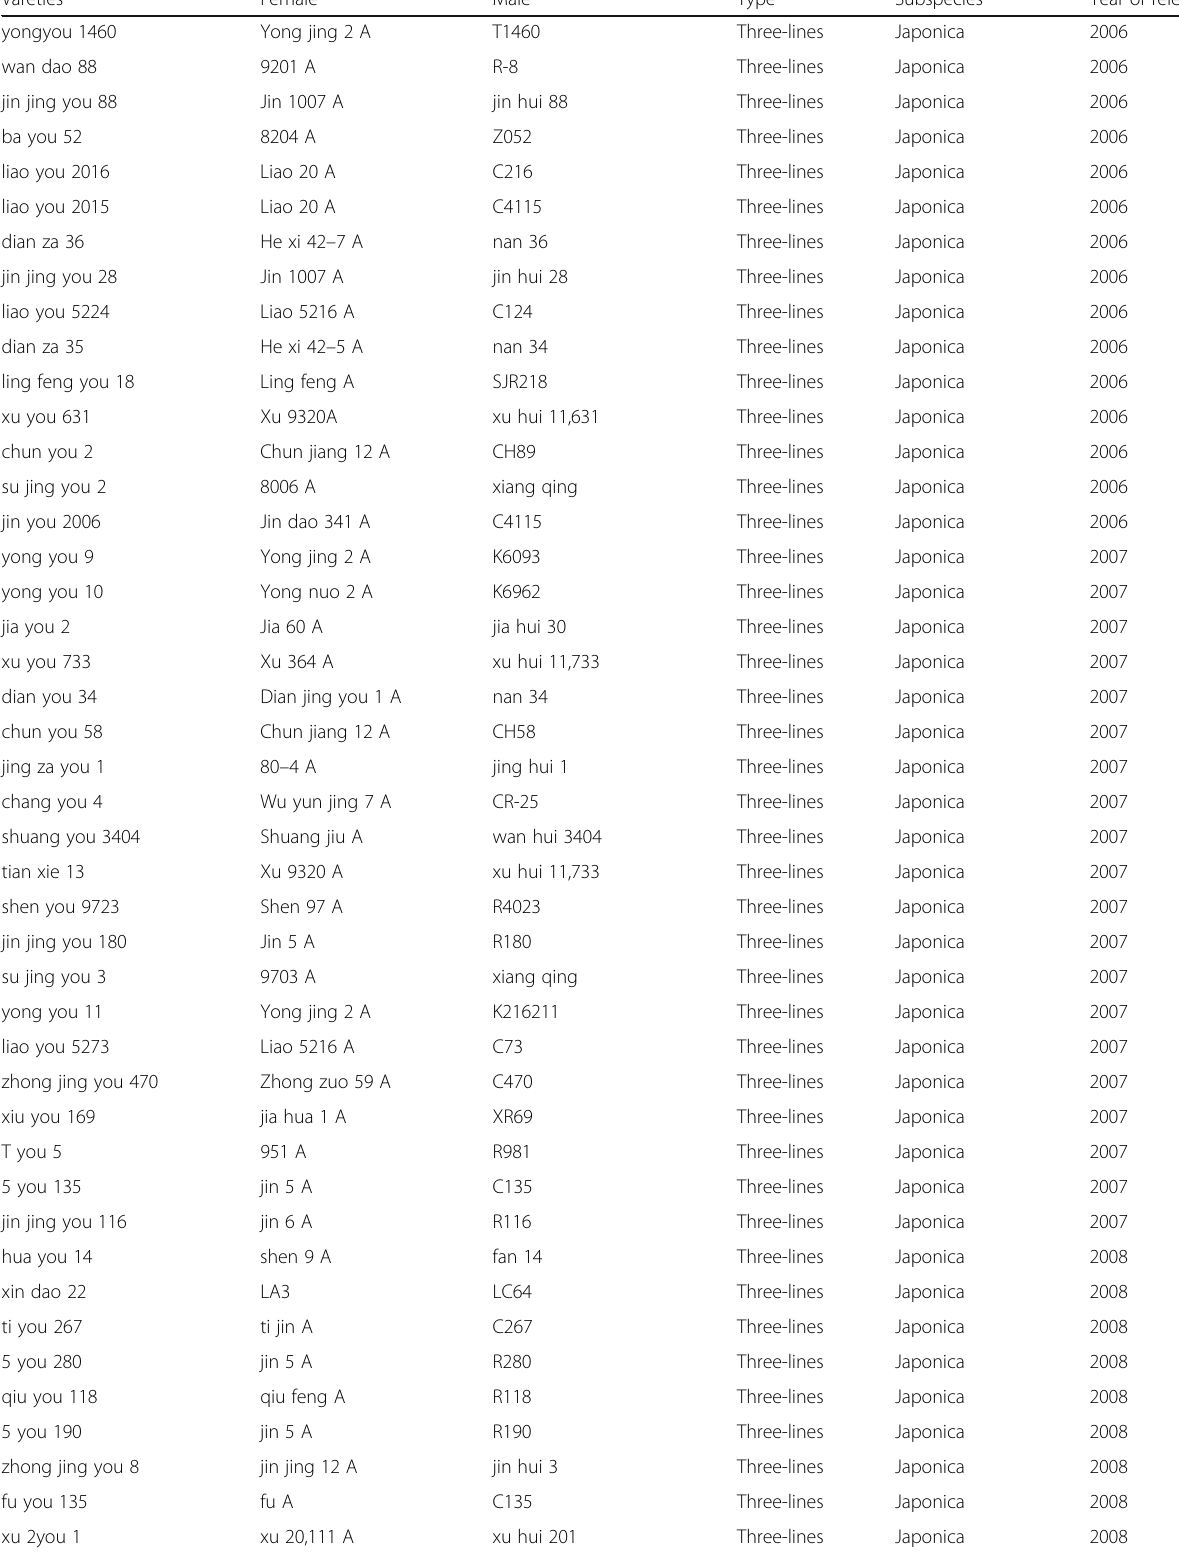
Table 1 List of hybrid japonica rice varieties bred in China (Continued)